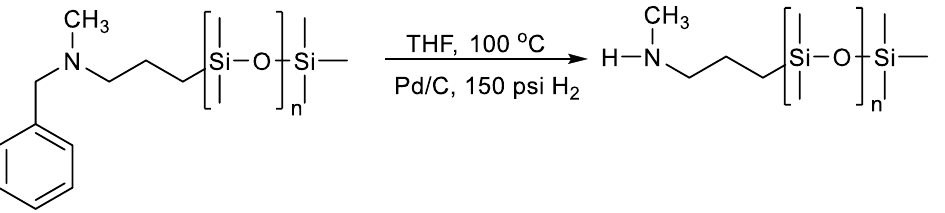
Figure 14. Synthetic Methodology for the Deprotection of the Amine Functionality on PDMS.